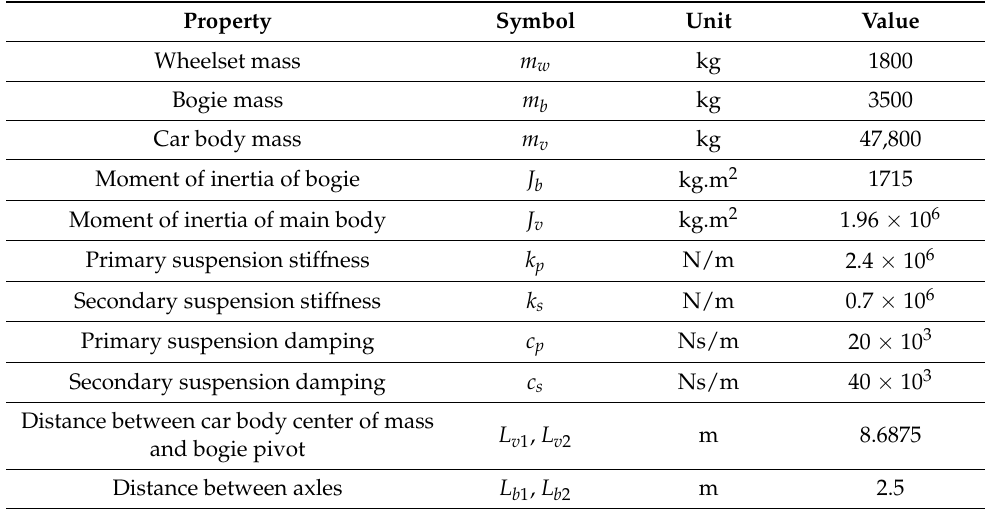
Table 2. Properties of the